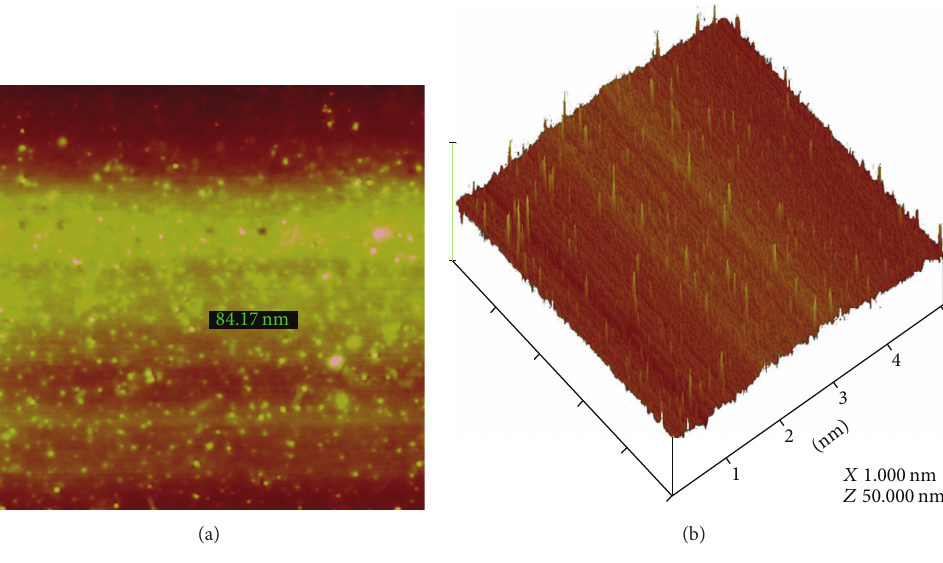
Figure 3: The AFM images of